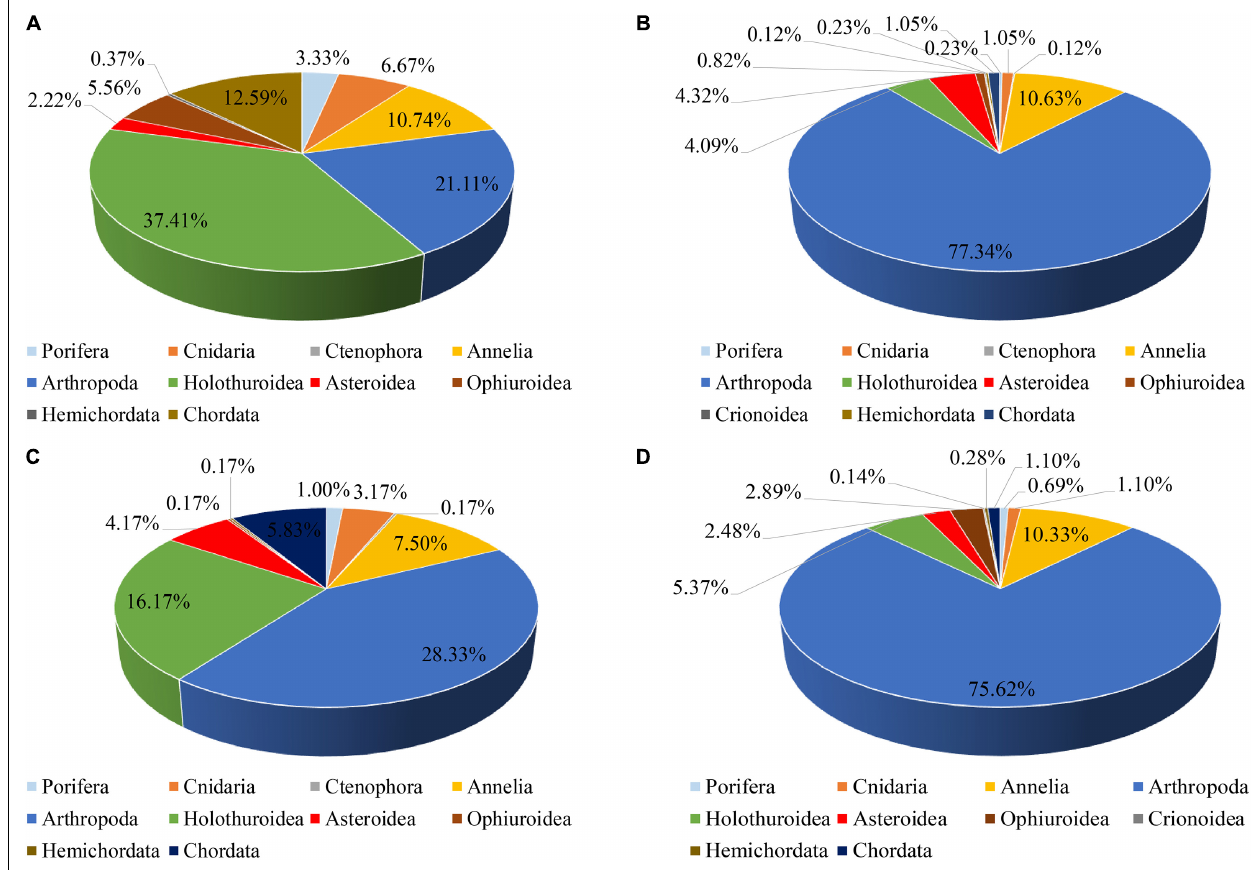
Mysidae spp. (25.1%) and Decapoda sp.2 (20.09%).